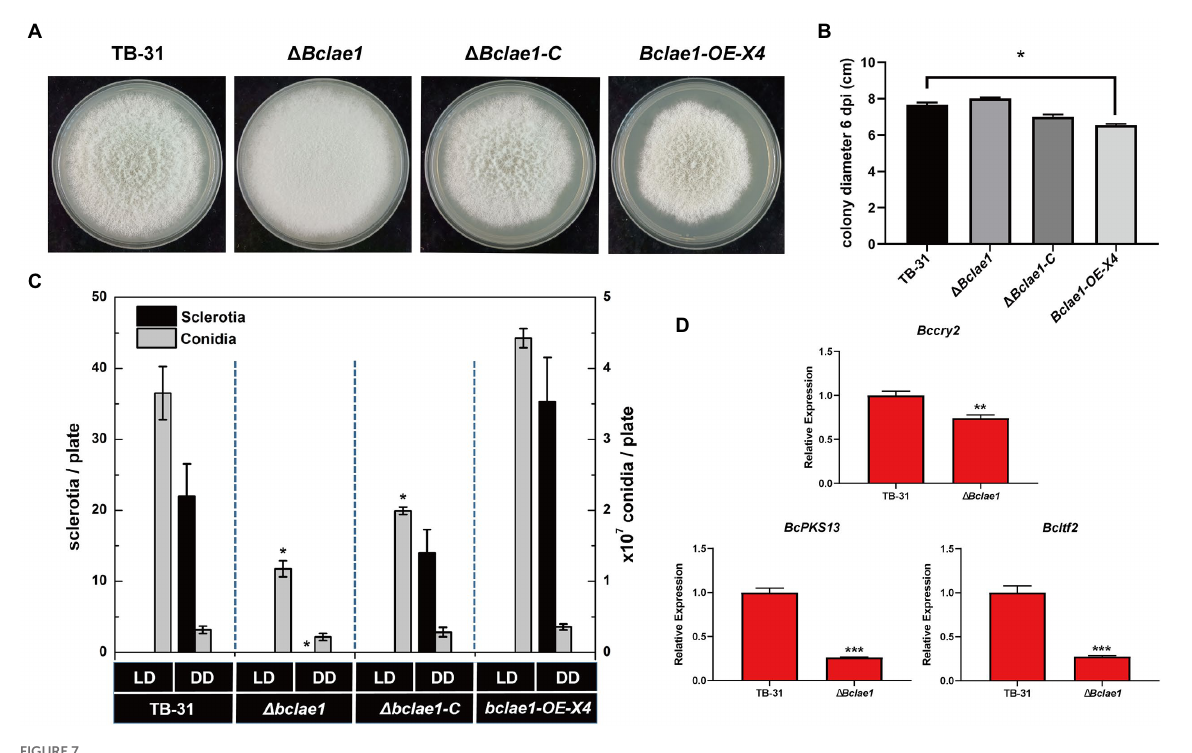
FIGURE 7 Deleting Bclae1 changes the growth, morphology, and reproductive development. (A) The TB-31, Δ Bclae1 , Δ Bclae1 -C (X7), and Bclae1 -OE-X4 mutants were photographed after 6 days of PDA growth under DD culture conditions, and the colony diameters were calculated (B) . Shown are means and SEM, n = 3 independent biological replicates. * p < 0.05 versus the colony diameter of the TB-31 group. (C) Under DD or LD conditions, TB-31, Δ Bclae1 , Δ Bclae1 -C (X7), and Bclae1 -OE-X4 mutants were counted for sclerotia and conidia numbers after 14 days of PDA growth. Shown are means and SEM, n = 3 independent biological replicates. * p < 0.05 versus the TB-31 group. (D) RT-qPCR examining the transcriptional levels of Bccry2 , BcPKS13 , and Bcltf2 in TB-31 and Δ Bclae1 . Shown are means and SEM, n = 3 independent biological replicates. ** p < 0.01/*** p < 0.001 versus the same genes of the TB-31